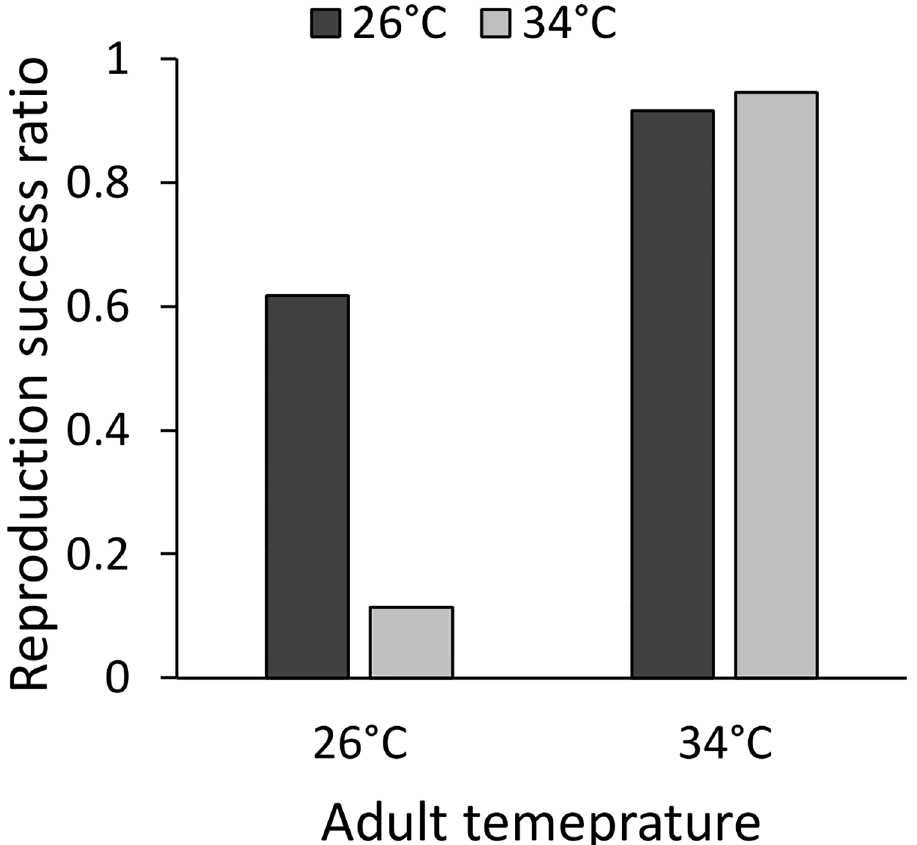
Fig 2. Adult temperature (X axis) positively affected the reproductive success rate the most (i.e., the proportion of pairs reproducing), but there was also an effect of parental growth temperature (dark and light columns represent lower and higher adult temperatures, respectively). Beetles raised under the higher temperature but acclimated as adults to the lower temperature demonstrated a lower reproductive success rate than those grown under and remaining at the lower